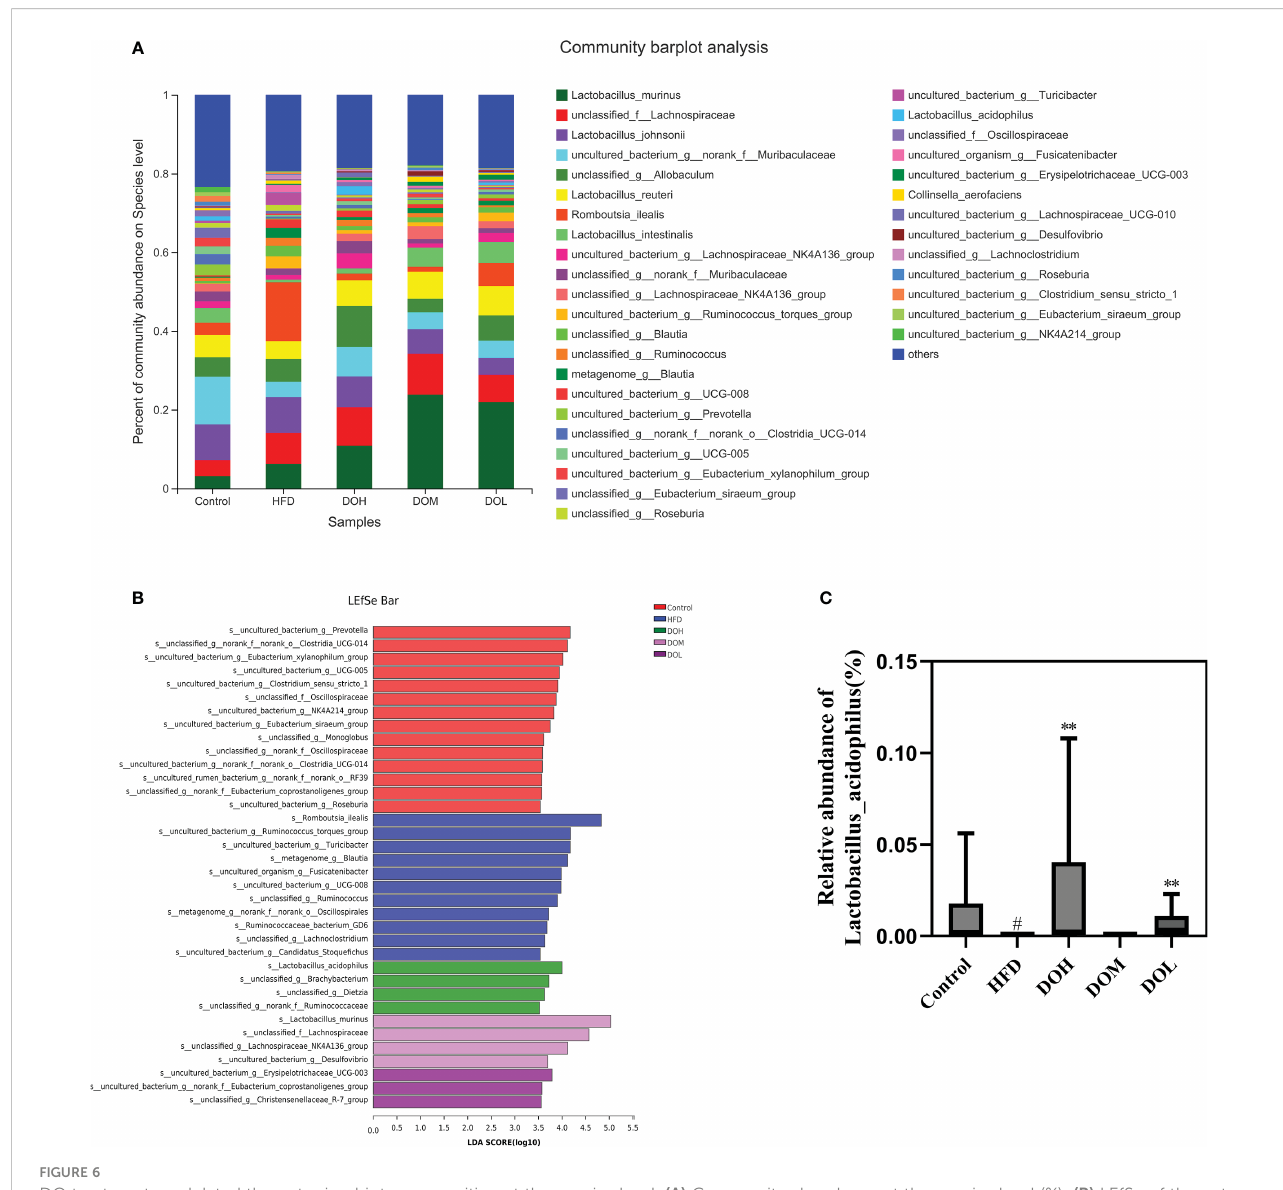
FIGURE 6 DO treatment modulated the gut microbiota composition at the species level. (A) Community abundance at the species level (%); (B) LEfSe of the gut microbiota at the species level; (C) relative abundances of Lactobacillus_acidophilus . Data are expressed as the mean ± SD (n=6). # p < 0.05 vs. the Control group; ** p < 0.01 vs. the HFD